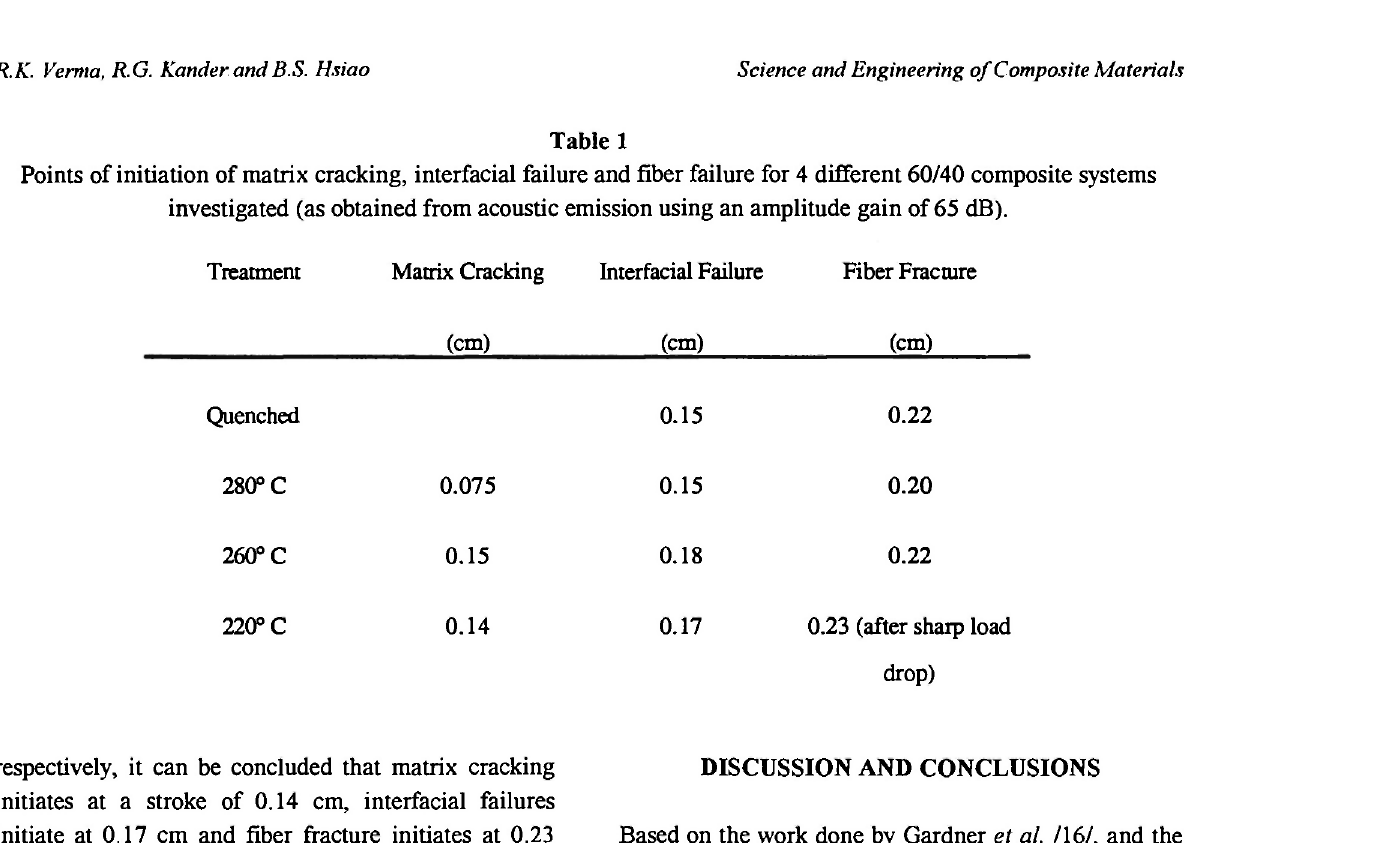
Points of initiation of matrix cracking, interfacial failure and fiber failure for 4 different 60/40 composite systems investigated (as obtained from acoustic emission using an amplitude gain of 65